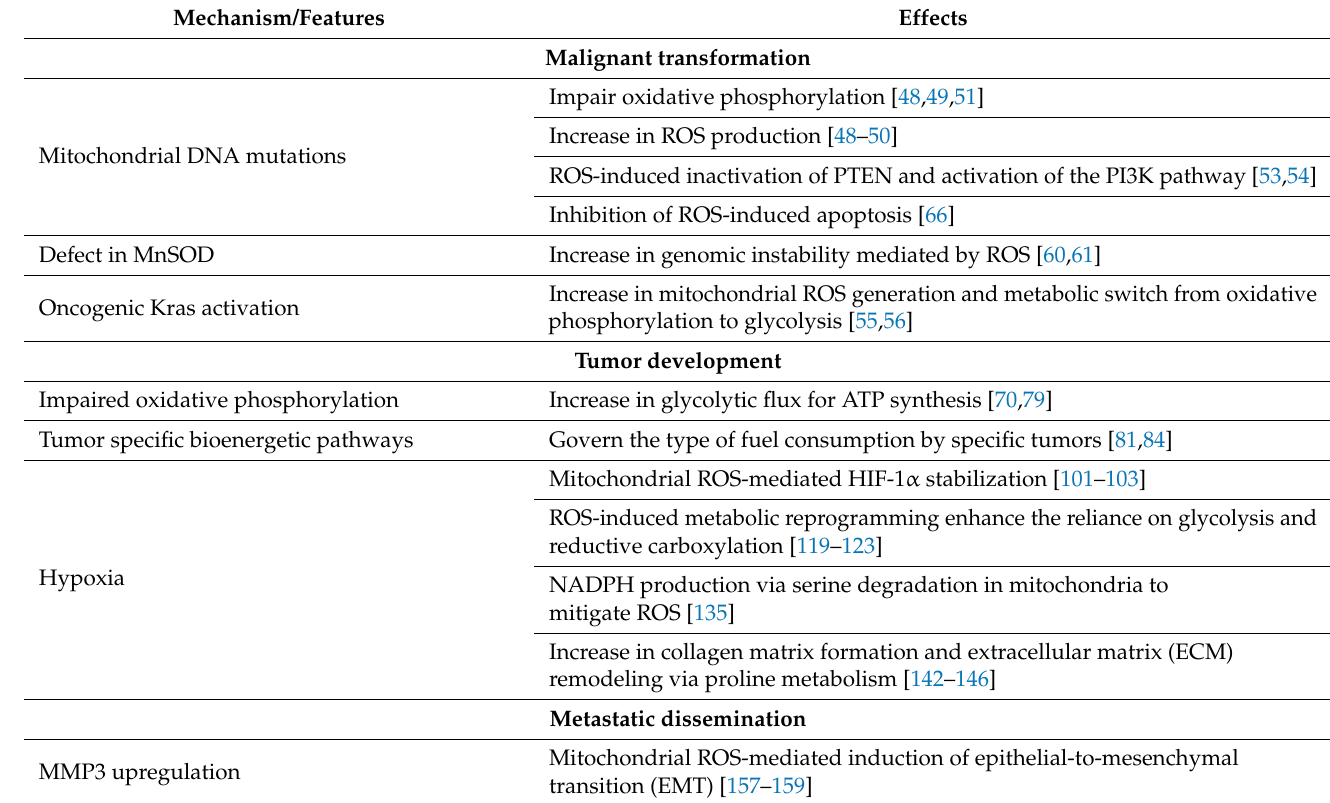
Table 1. Key aspects of mitochondrial redox metabolism during different stages of cancer progression.